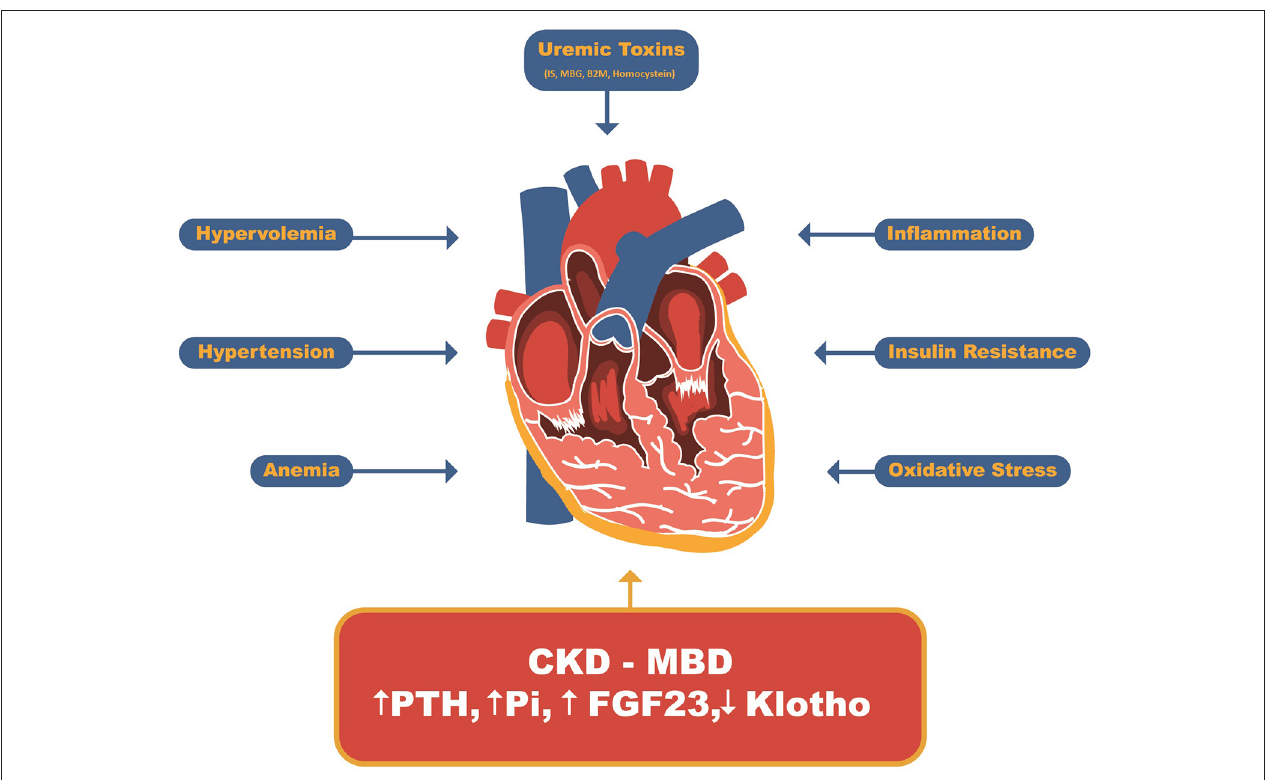
FIGURE 2 | Uremic Cardiomyopathy related factors. Beyond uremic toxins such as indoxil sulfate, marionobufagenin, β 2-microglobulin and homocysteine and other CKD-related factors such as hypervolemia, hypertension, anemia, insulin resistance, inflammation and oxidative stress, the CDK-MBD has recently been stood out as major player related to uremic cardiomyopathy. IS, Indoxyl sulfate; MBG, Marionobufagenin; P, Phosphate; B2M, β 2-Microglobulin; PTH, parathyroid hormone; FGF23, Fibroblast growth factor